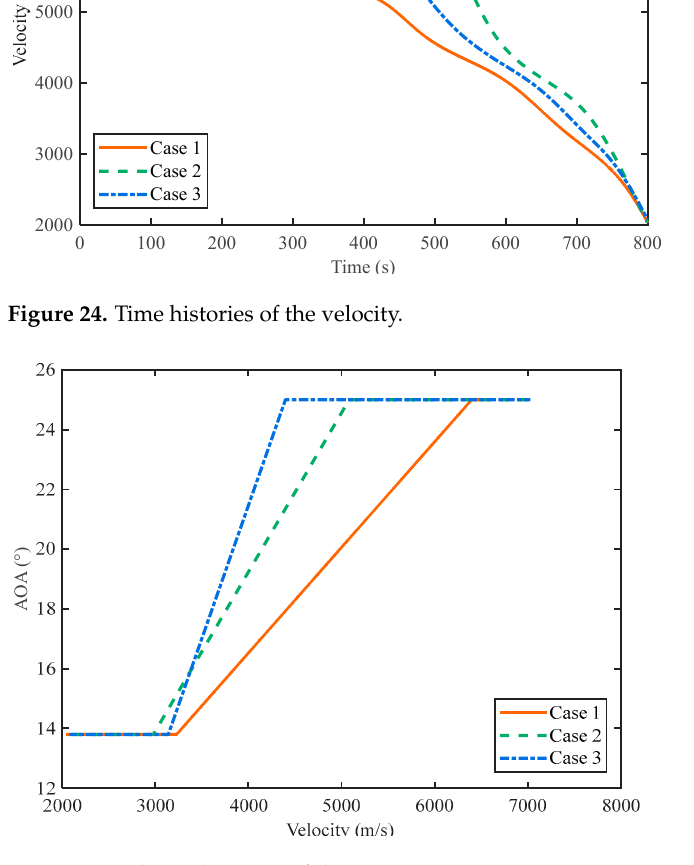
Figure 25. Velocity histories of the AOA.